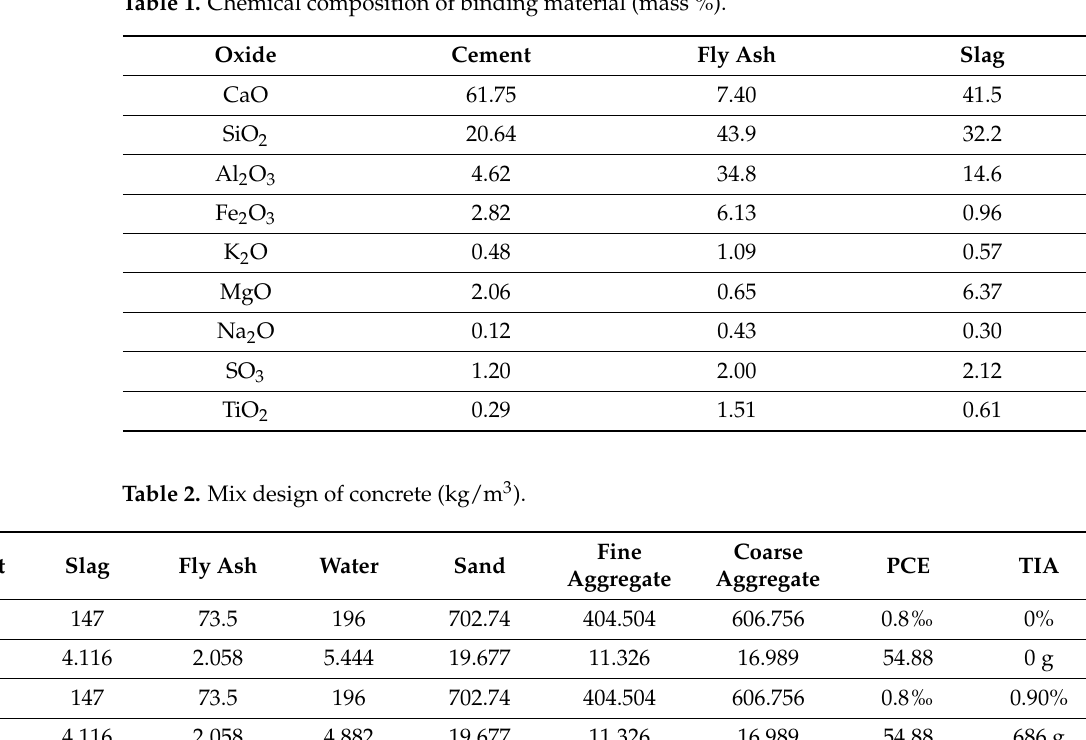
Table 1. Chemical composition of binding material (mass %).